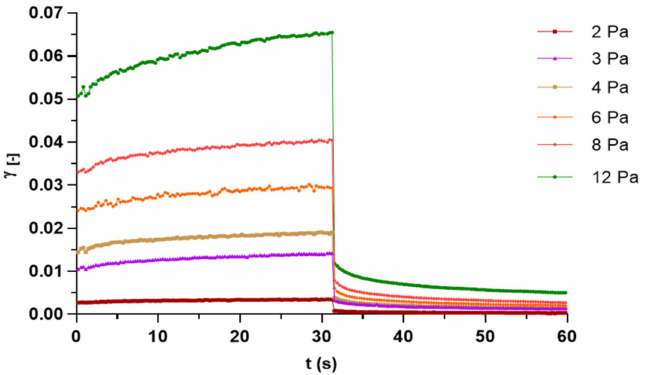
Figure 1. Apparent viscosity as function of shear rate in Carbopol-based formulation.